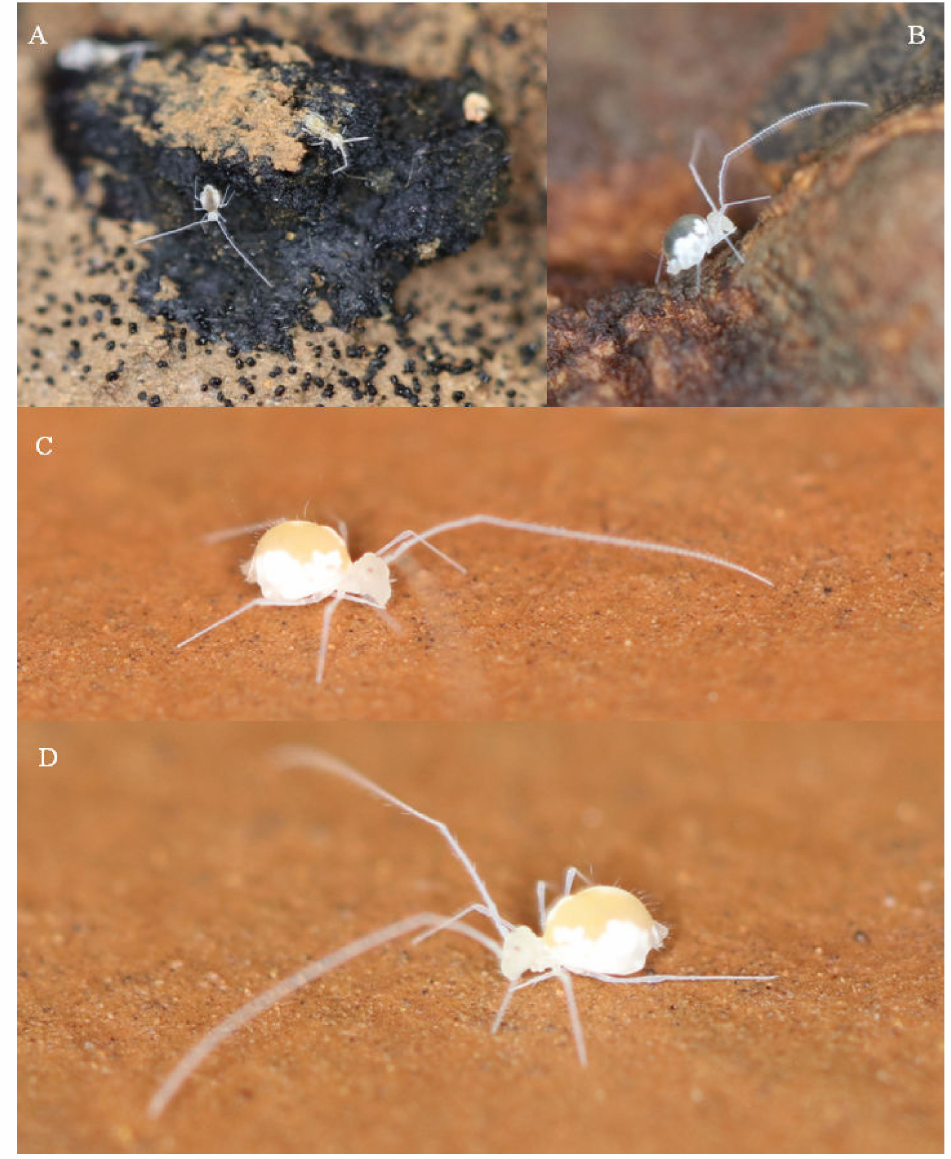
Figure 2. Living specimens of Troglobentosminthurus luridus gen. nov. sp. nov.: ( A ) one specimen apparently feeding on a bat guano pile in the Lapa dos Peixes II cave (another springtail specimen in the same pellet); ( B ) specimen walking around a dry bat guano pile in the Lapa dos Peixes II cave; ( C , D ) specimens freely walking on the cave muddy sediment in the deeper portion of the Gruna da Á gua Clara